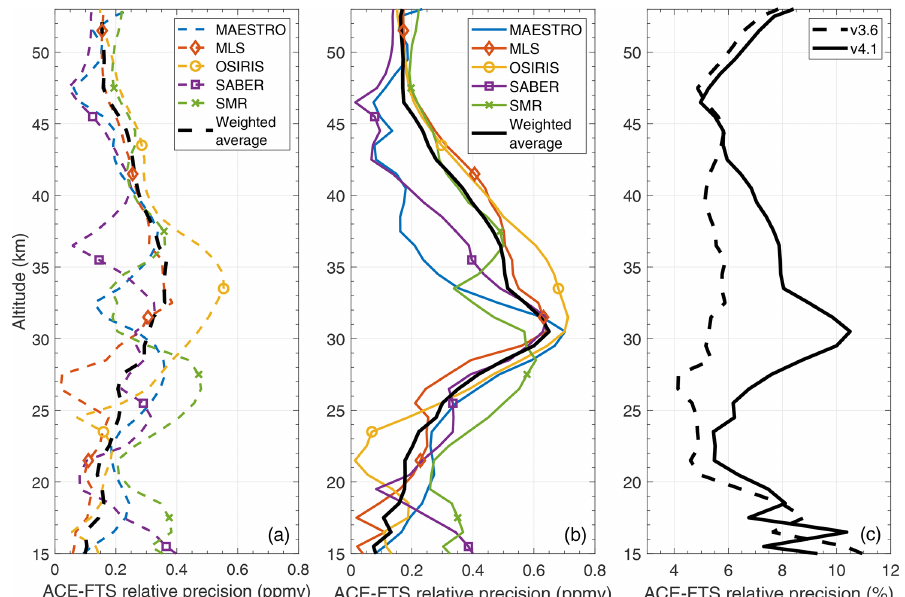
Figure 3. ACE-FTS relative precision estimates for (a) v3.6 relative to INST in ppmv, (b) v4.1 relative to INST in ppmv, and (c) weighted mean profiles in percent.